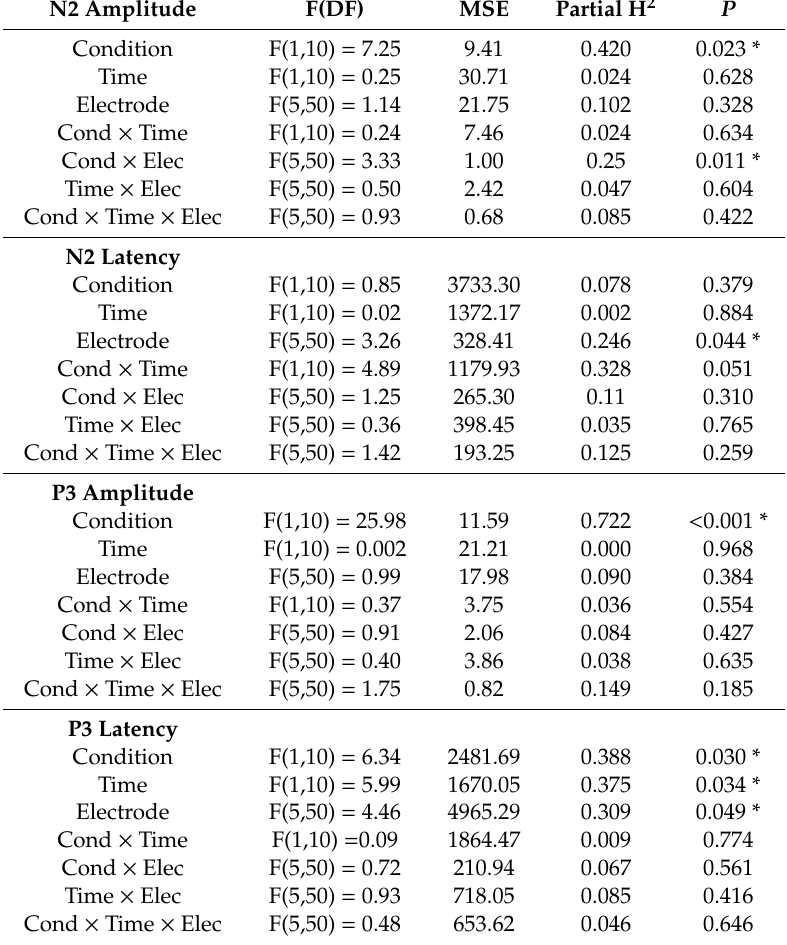
Figure 4. Mean N2 peak amplitude ( a ) and peak latency ( b ) averaged across participants ( N = 11) and across fronto-central electrode sites (F3, Fz, F4, FC1, FC2, Cz) to congruent and incongruent trials at rest (black) and following acute exercise at moderate intensity (grey). Error bars depict standard error values. The DotPlot visualizes the individual data (light grey) for the congruent and incongruent condition as well as the change from rest to after-exercise (dashed lines).